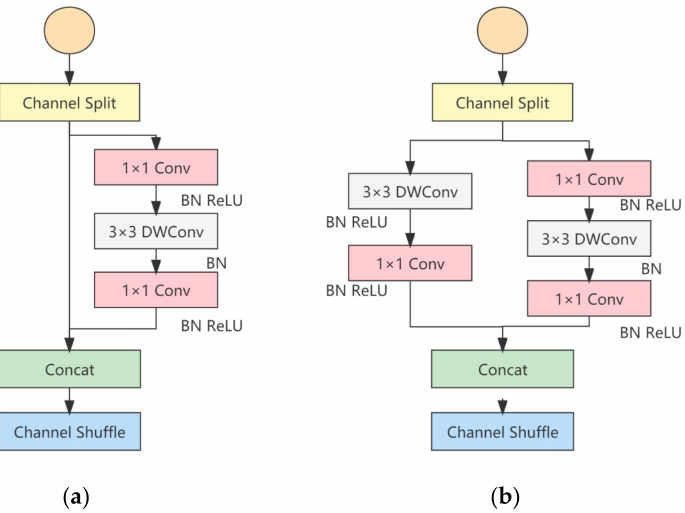
Figure 4. Structure of ShuffleNet V2 model. ( a ) ShuffleNet V2 structure. ( b ) ShuffleNet V2 structure.